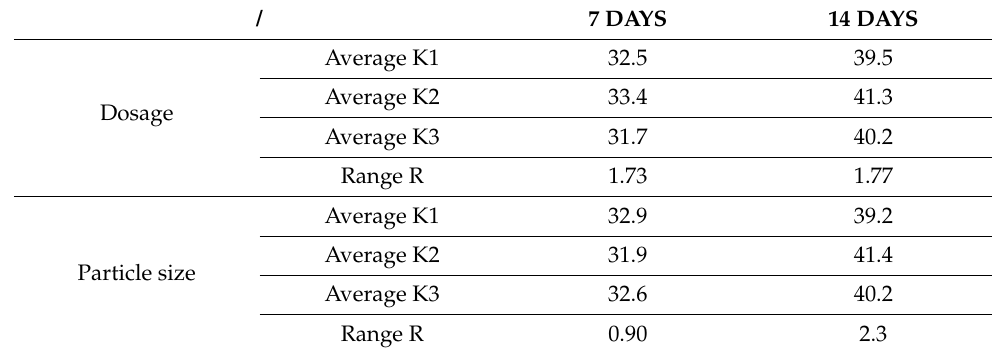
Table 3. Comparison of mass loss rate and strength loss rate of ER concrete with different